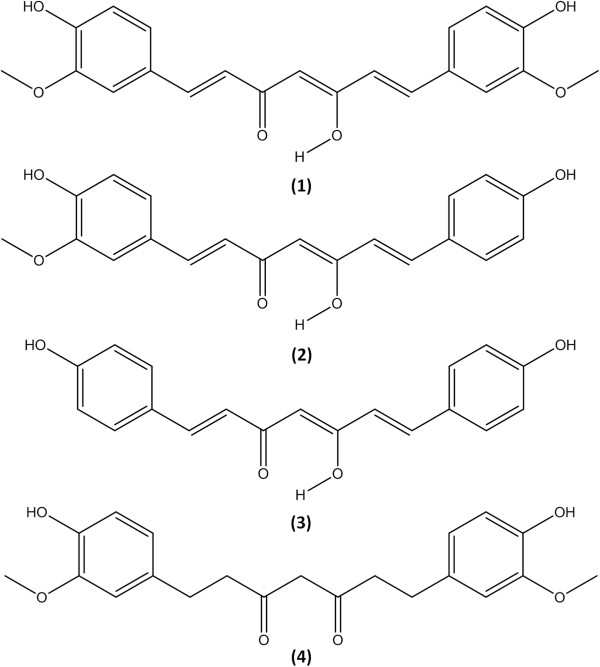
Structures of the curcuminoids. Curcumin (1), demethoxycurcumin (2), bisdemethoxycurcumin (3), and tetrahydrocurcumin (4).